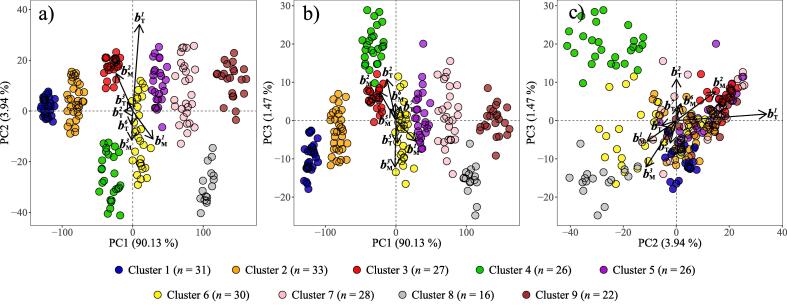
Principal component analysis biplots of the pre-treated and subset (n=239) XRPD data (Section 3.2.3), with the total and M3 nutrient balances (Table 3) added as supplementary variables. Only balances that displayed a discernible vector length are included.